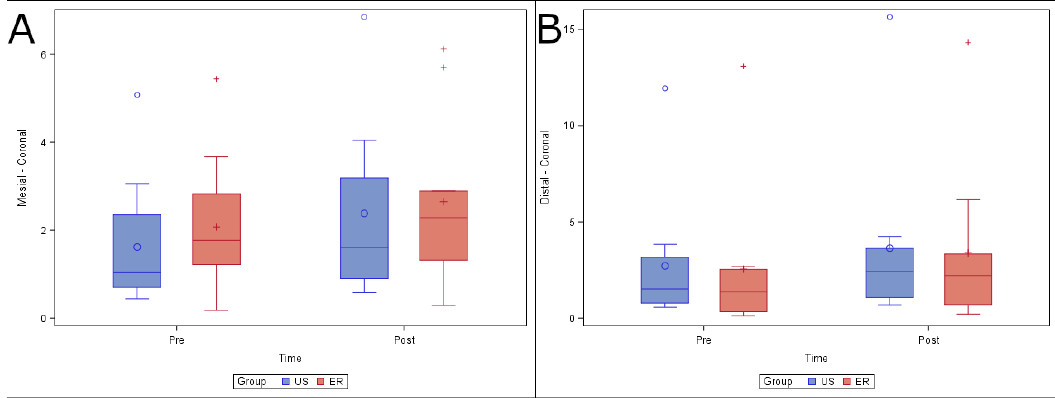
Figure 4. ( A ) Box plot of volume of dentin removed preoperatively and postoperatively, comparing the US and ER study groups at the coronal level in the mesiobuccal and ( B ) distal root canal systems. No statistically significant differences ( p = 0.3232) were found in the changes in volume at the medial root third between the US (0.56 ± 0.47 mm 3 ) and ER (0.39 ± 0.21 mm 3 ) study groups in the mesiobuccal root canal system. In addition, there were no statistically significant differences ( p = 0.8447) in the change in volume between the US (0.61 ± 0.45 mm 3 ) and ER (0.65 ± 0.47 mm 3 ) study groups in the distal root canal system (Figure 5).